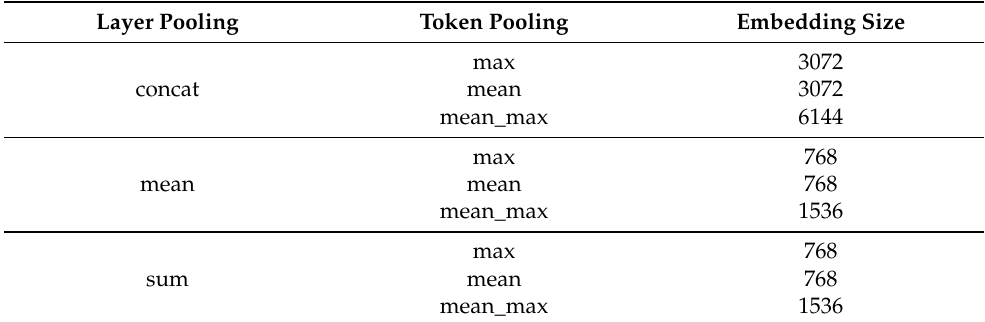
Table 7. Sentence vector sizes derived using different pooling strategies with four hidden